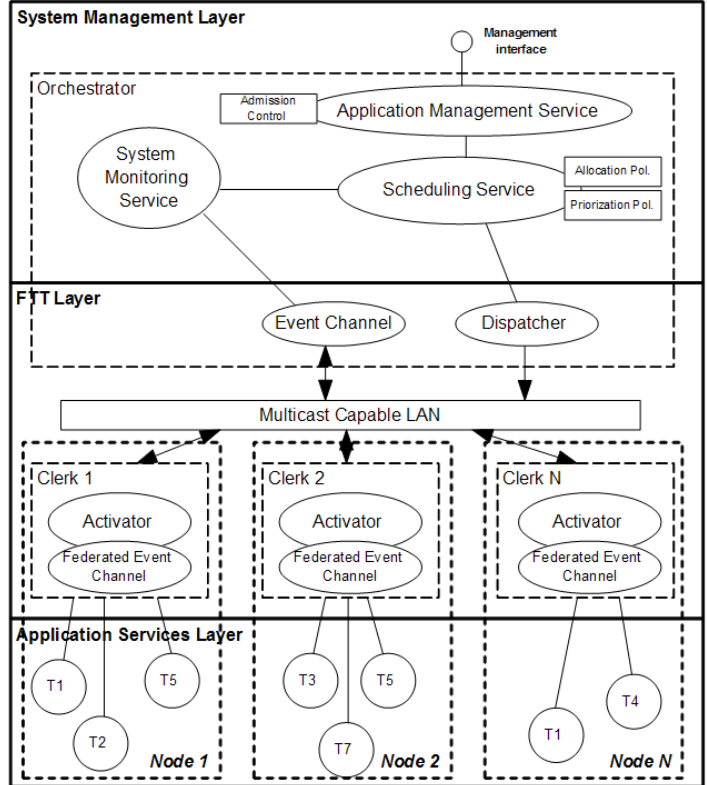
Figure 3. FTT-MA